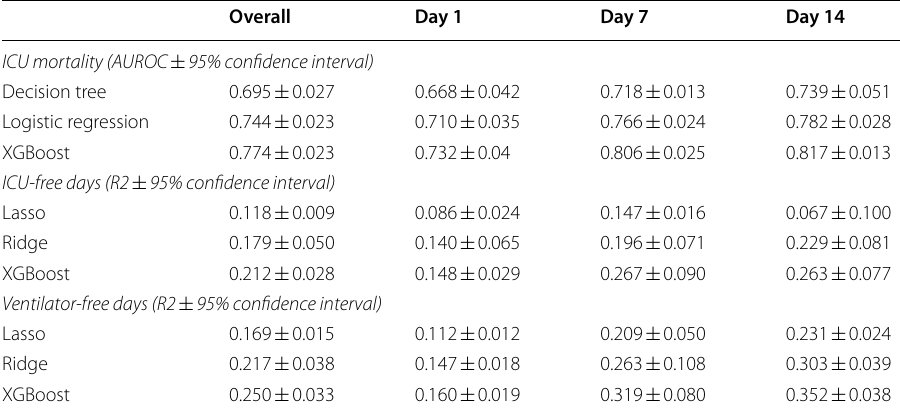
Model performance is shown for ICU mortality, ventilator‑free days at day 30, and ICU‑free days at day 30 across the days of IMV AUROC area under the receiver operating